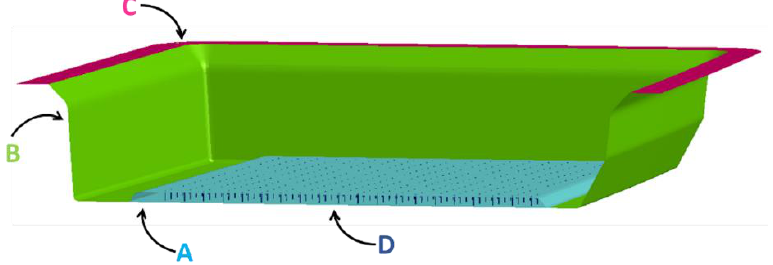
Figure 2. Numerical model description.